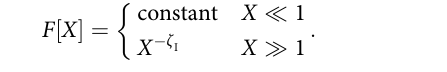
Fig. 4 Characteristic torque features in defect spin scenario. a , b Angle-dependence of the magnetic torque τ for identical impurity and bulk susceptibility = ~ χ contributions ( ~ χ ¼ 1), conventional bulk susceptibility scaling ( ζ B = 0), and different ratios of induced staggered ( c s ) and induced uniform ( c u ) spin I u density contribution. The total torque is indicated in solid black, the bulk contribution in dashed gray and the impurity contribution in dotted-dashed blue = ~ χ lines. c Angle shift θ 0 in terms of ~ χ for indicated ratios c s / c u . d Impurity torque susceptibility τ I / H 2 as a function of temperature T for various magnetic I u fi elds H (compare with ref. 17 , Fig. 4d). e Angle shift θ 0 as a function of temperature for various magnetic τ T ζ I = H 2 showing apparent H / T scaling over several orders of magnitude (compare with ref. 17 , Fig. 5a). Plots d – f employ parameters from fi tting the I experimental (Fig. 4b), which leads to an overall shift of the total torque curve. The experimentally observed angle shift 17 corresponds to c s / c u ≈ exceeds the uniform defect moment.